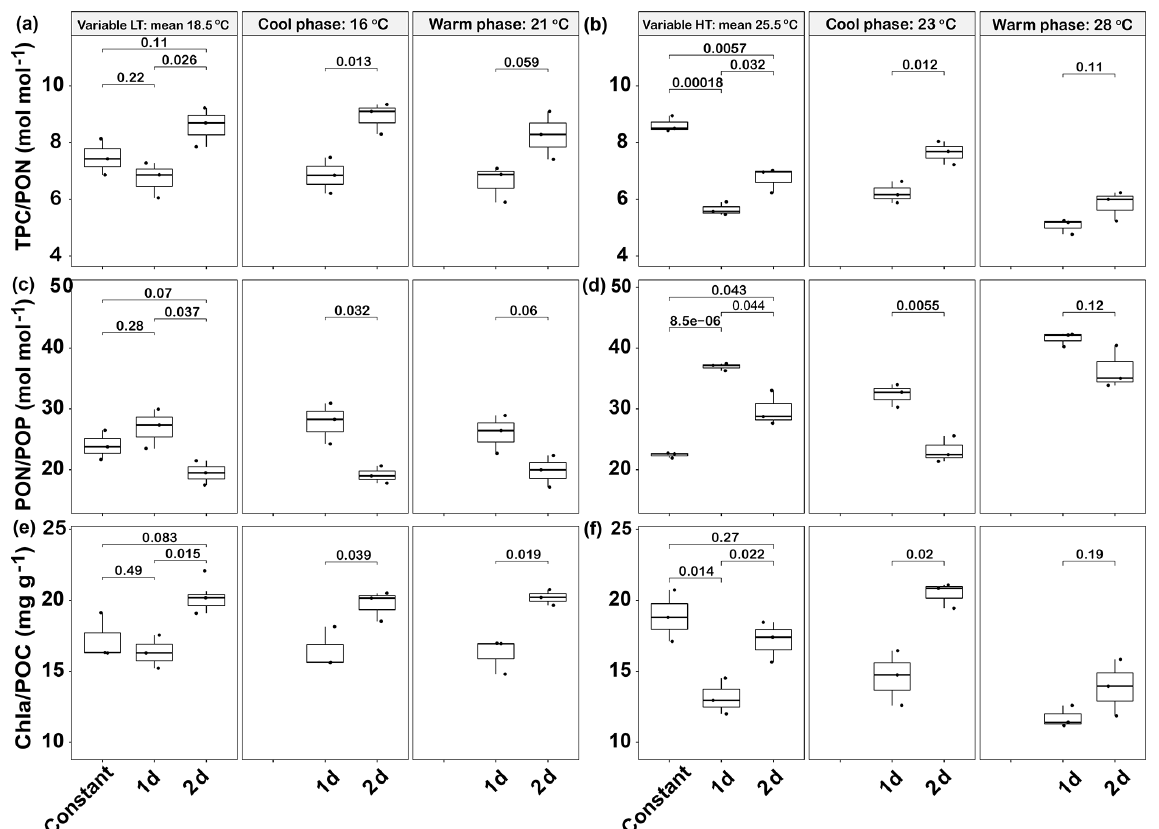
Figure 7. Responses of Emiliania huxleyi elemental ratios in two thermal variation frequency treatments (1 and 2d) compared to constant temperatures for TPC / PON ( a low and b high temperature), PON/POP ( c low and d high temperature) and Chl a / POC ratios ( e low and f high temperature). LT: low temperature; HT: high temperature. The thick black line in the boxplots represents median values for each experimental treatment; the whiskers on the boxplots indicate 1.5 × interquartile range. Listed p values with their respective brackets denote the statistical significance between two